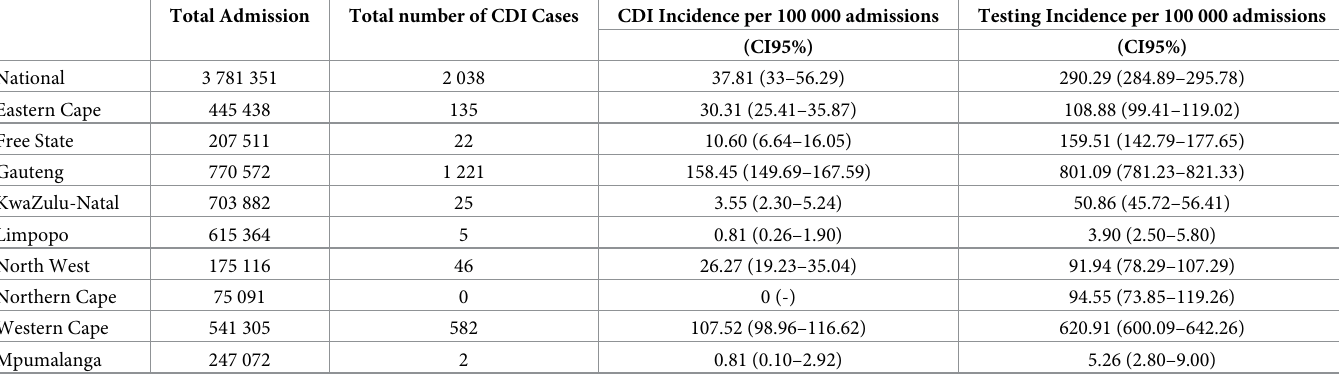
Table 1. Incidence of CDI, CD testing and positivity rate by province per 100 000 admissions.